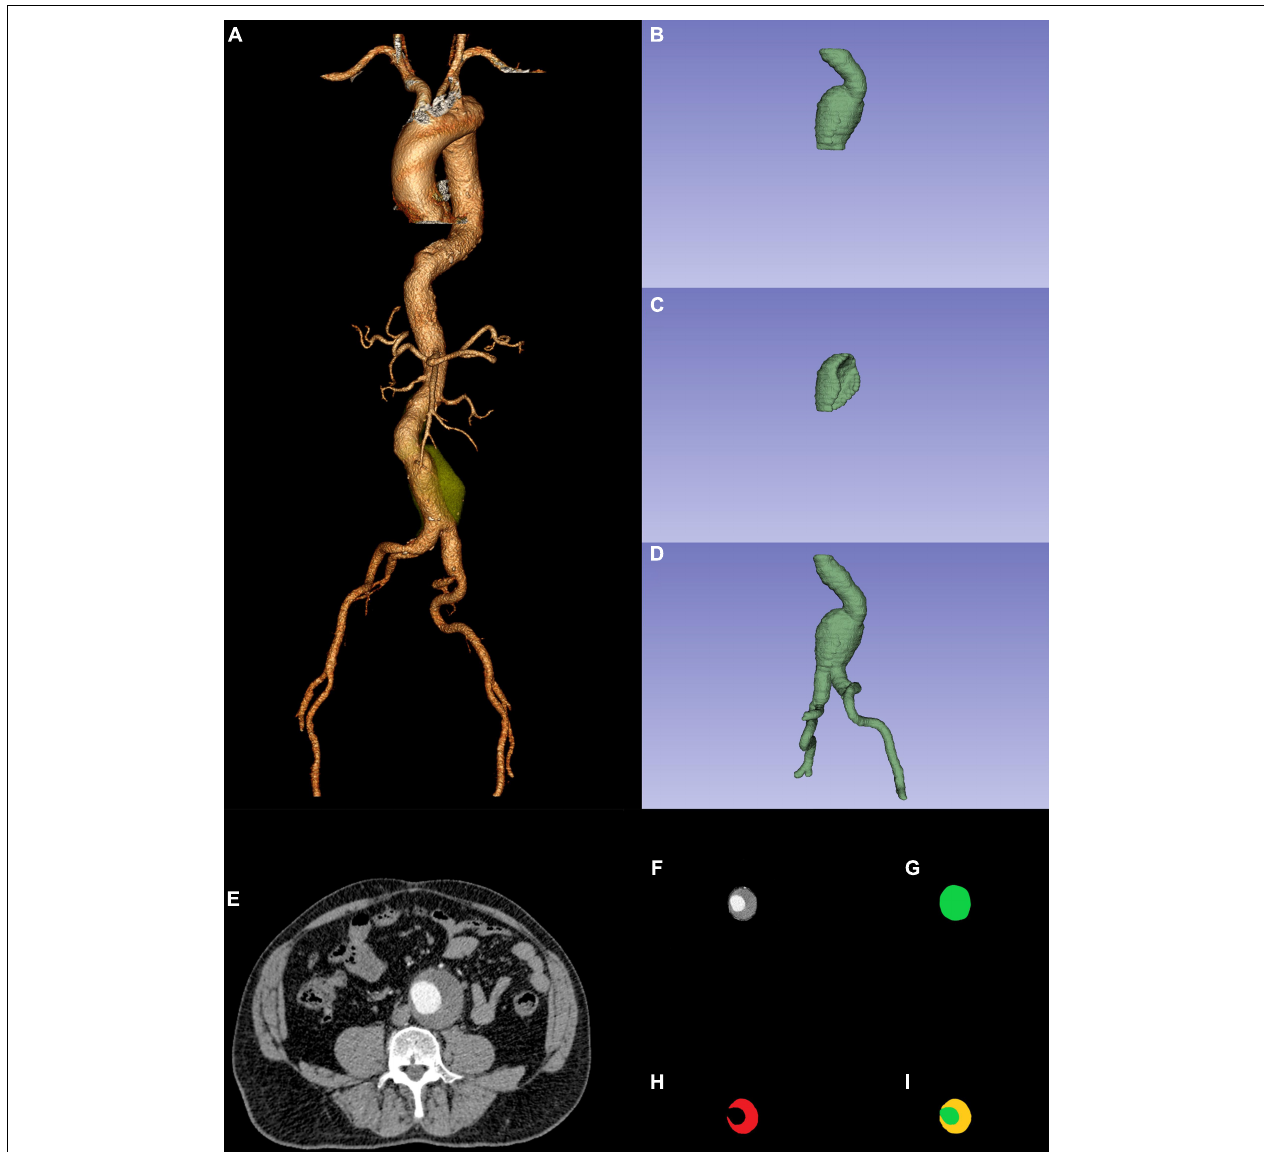
FIGURE 1 | Preoperative CTA reconstruction (A) ; AAA sac ROI (B) ; ILT ROI (C) ; AAA ROI (D) ; AAA original ROI CTA slice (F) was the combination between AAA ROI CTA slicer (G) and original ROI CTA slice (E) ; CTA slicer (I) was the combination between AAA sac ROI CTA slicer (G) and ILT ROI CTA slicer (H) . CTA,